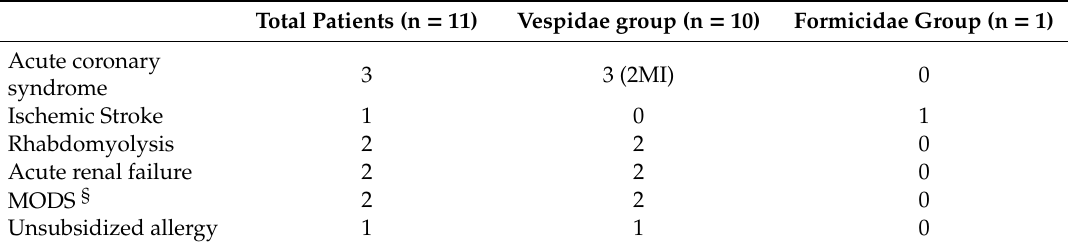
Table 5. Statistics for the reason for